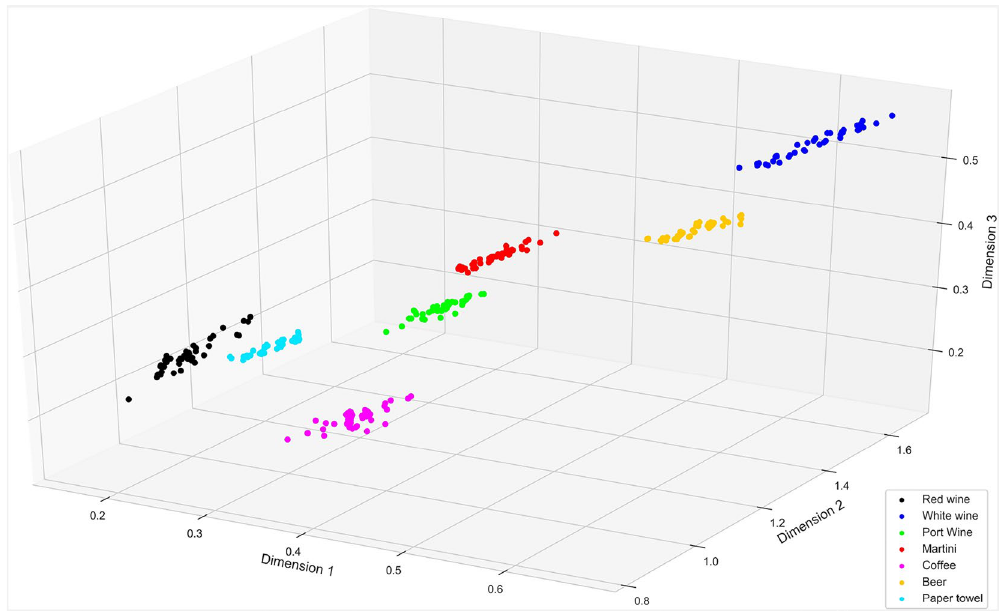
Figure 7. Encoder output for paper1 (ROI 20)—spectra in lower dimensions.